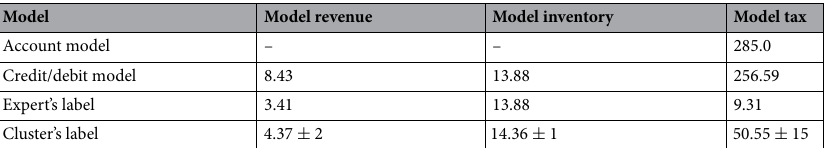
Table 1. This table shows the MAPE score for the three models of company A for the relationship based on the profit margin, the purchase and delivery of goods, and the tax payments related to sales. For the models that use the Cluster’s labels we added the standard deviation over 10 repetitions of the experiment. The lowest score is obtained by the Expert’s